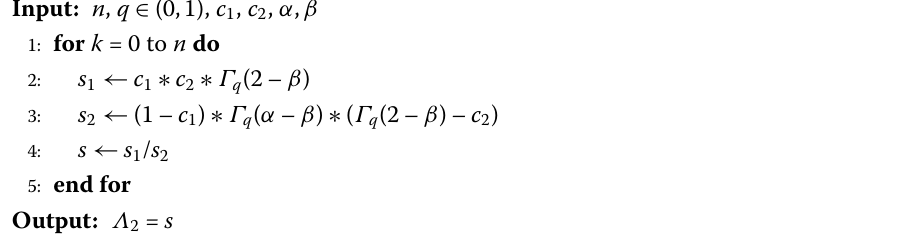
Algorithm 7 The proposed method for calculating Λ